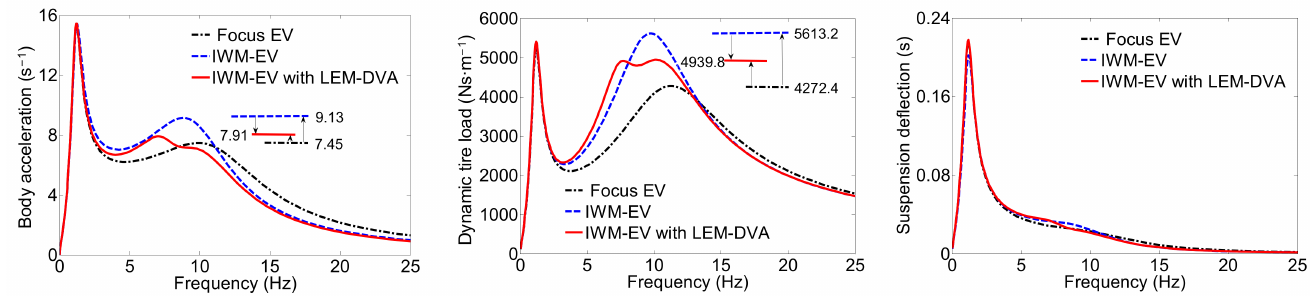
Figure 10. Optimization results.